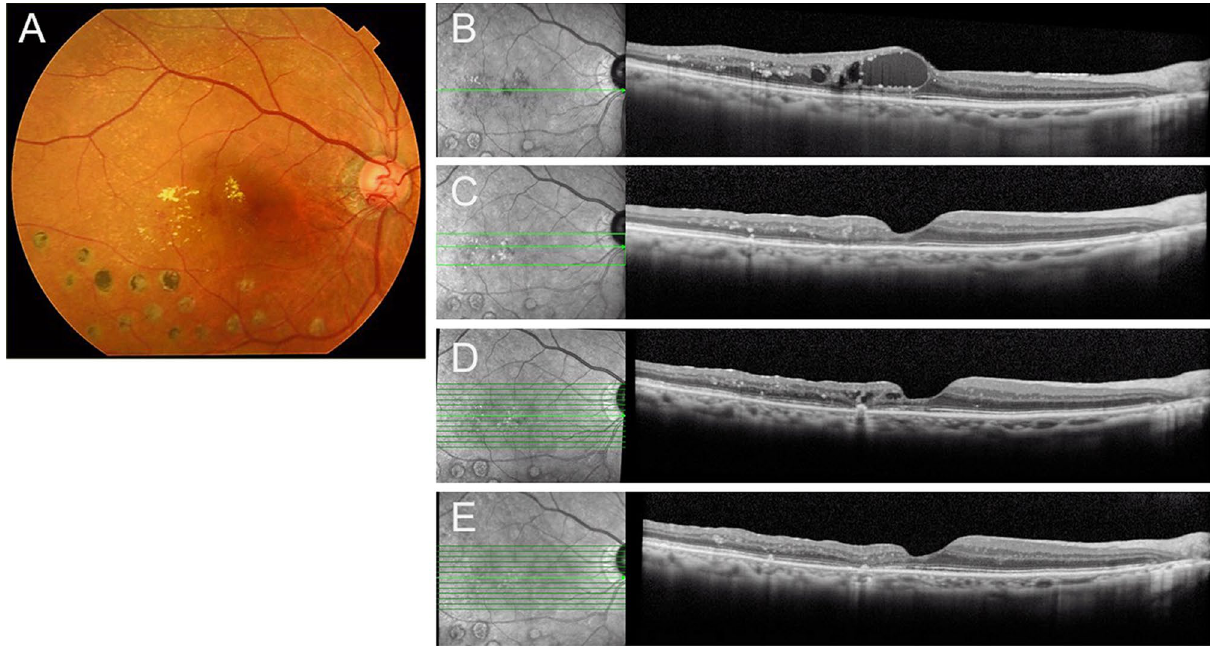
Figure 5. An 86-year -old woman was referred to us for the treatment of prolonged resistant cystoid macular edema (CME) secondary to branch retinal vein occlusion in the right eye. At the initial visit, best corrected decimal visual acuity (BCVA) was 0.6. A fundus examination revealed a CME and postlaser chorioretinal scars ( A ). The foveal cystoid cavity showed higher reflectivity compared to the vitreous on optical coherence tomography finding ( B ). Cystotomy and fibrinogen clot removal were performed for the treatment of CME. CME subsided immediately after surgery with no recurrence during the follow-up period of 12 months ( C 1 month, D 6 months, E 12 months after the surgery).The patient had BCVA of 1.0 at the last medical examination.